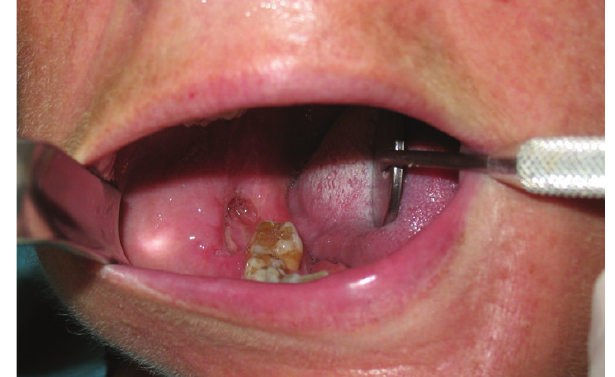
Figure 2: Preoperative radiographic appearance of radiolucent area back to tooth 47.